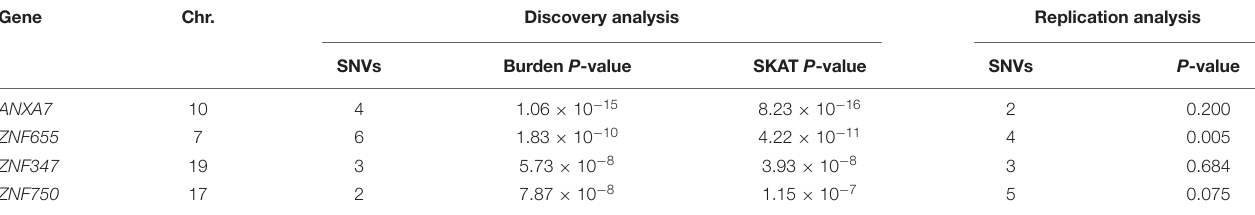
TABLE 3 | The results of gene-based analysis and validation using the in silico meta-GWAS dataset. Gene